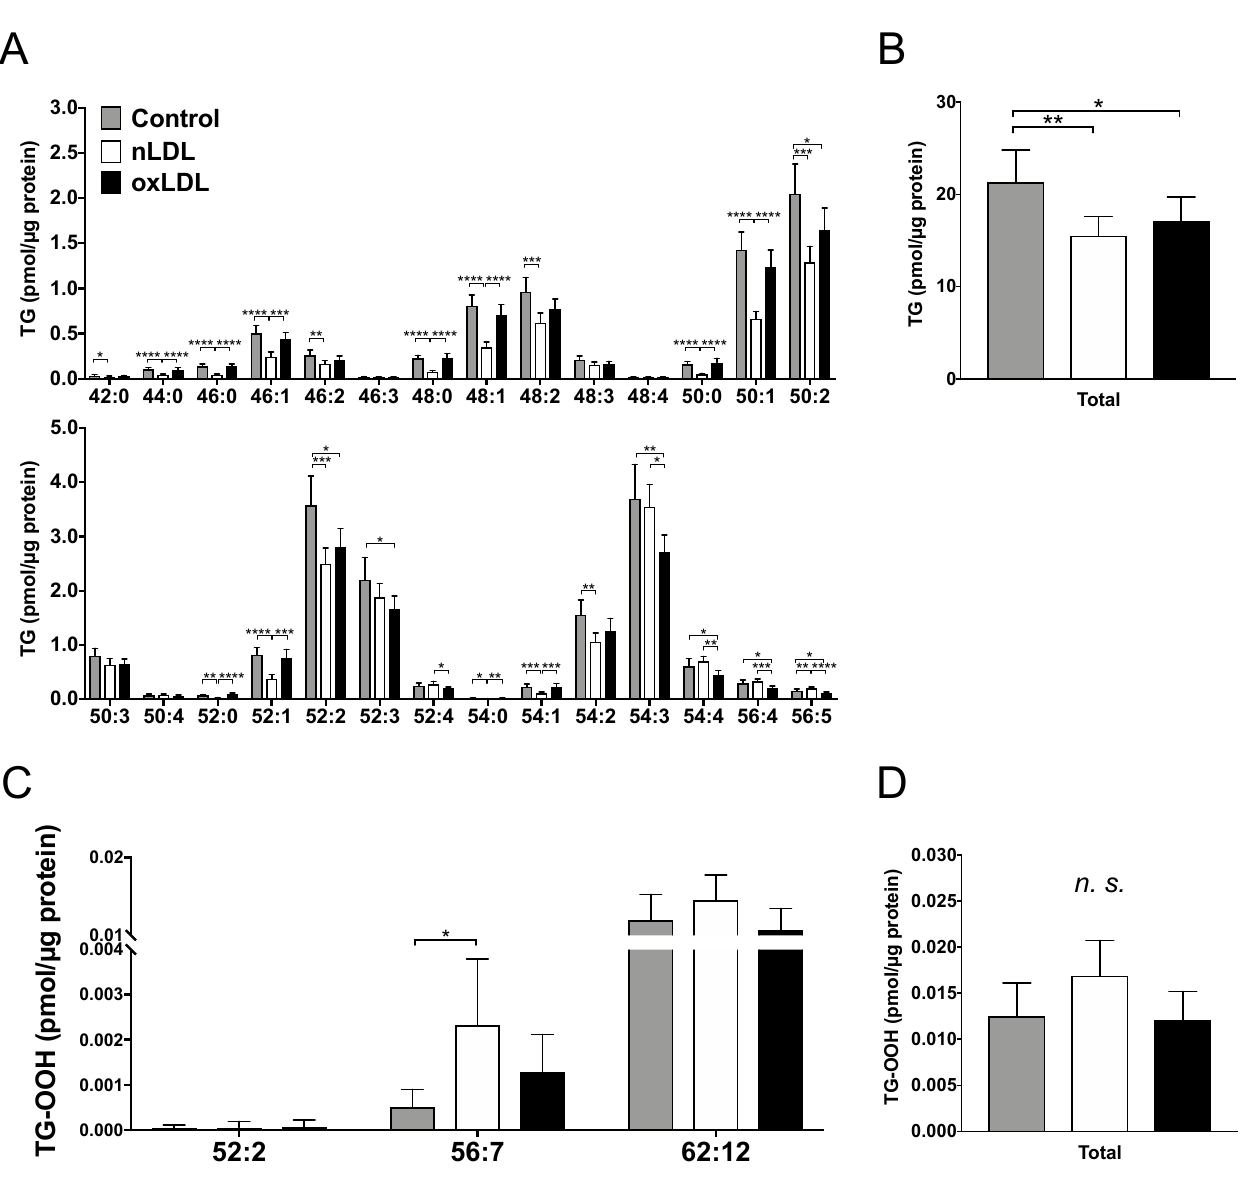
Figure 4. Comparison of TG and TG-OOH species in the LDL-supplemented C3A cells detected using Orbitrap LC-MS/MS. ( A ) TG species. ( B ) The sum of TGs detected in this experiment. ( C ) TG-OOH species. ( D ) The sum of TG-OOHs detected in this experiment. Results are shown as mean ± standard deviation. n = 6. One-way ANOVA with Tukey’s multiple comparisons test, * p < 0.05, ** p < 0.01, *** p < 0.001, **** p < 0.0001, n.s. not significant. Seventeen PC molecular species were detected in LDL-supplemented